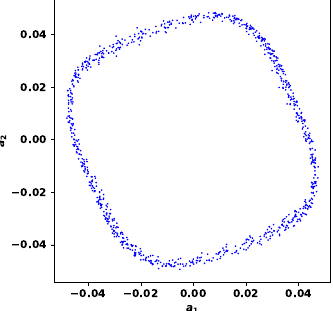
Figure 14. Phase diagram of the first two modes in the supper-upper